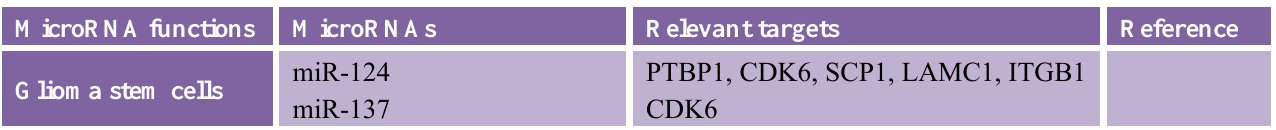
Table 1. List of miRNAs discussed in the text with their relevant functions and targets in GBMs or other